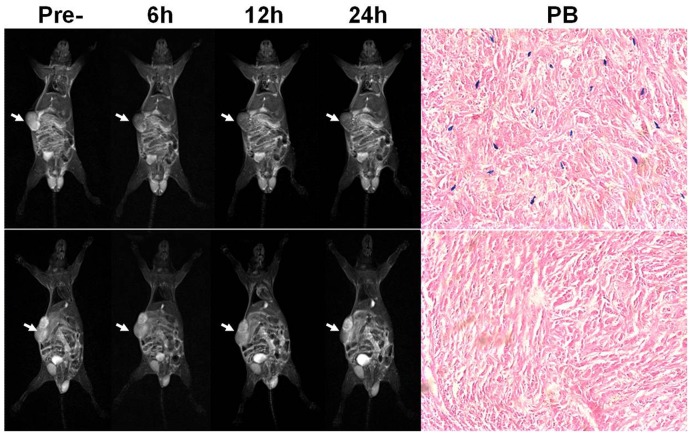
MRI of 7F5@Au/Fe3O4 targeting tumor cells in vivo.PC-3 tumor-bearing mice administered 7F5@Au/Fe3O4 nanoparticles demonstrated marked decreases in T2w tumor signal intensity 6, 12, and 24 hrs post-infusion (top row). No clearly appreciable tumor signal changes were observed for SMMC -7721 tumor-bearing mice at any of the three post-infusion time points (bottom row). Prussian blue staining (PB) showed that Au/Fe3O4 nanoparticles depicted as punctate blue-stained foci in the PC-3 tumor tissues; these deposits were not observed within SMMC-7721 tumor tissues. Scale bars, 10 mm for MRI and 50 µm for Prussian blue staining image.